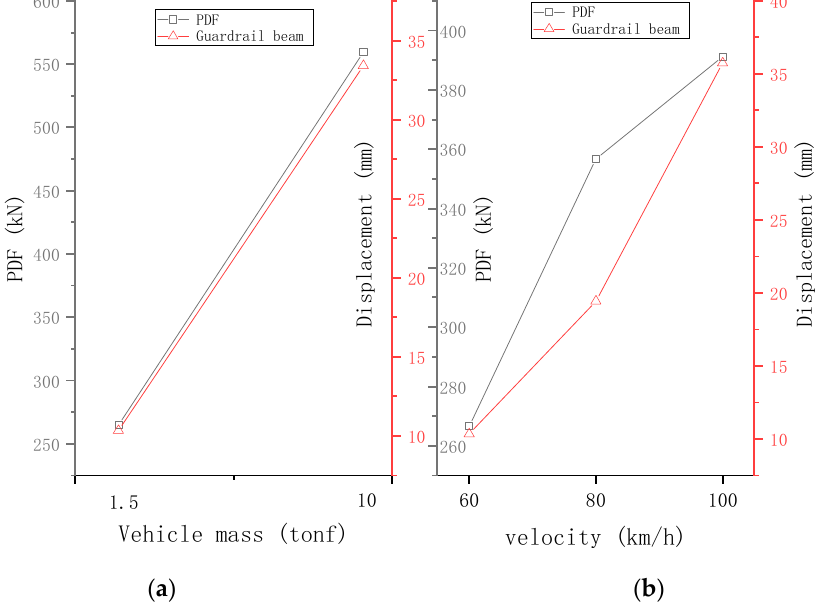
Figure 21. Effects of ( a ) vehicle velocity and ( b ) vehicle mass on PDF and maximum displacement of the guardrail beam.